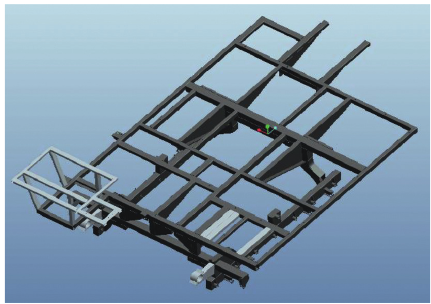
Figure 6: Modeling diagram of the chassis